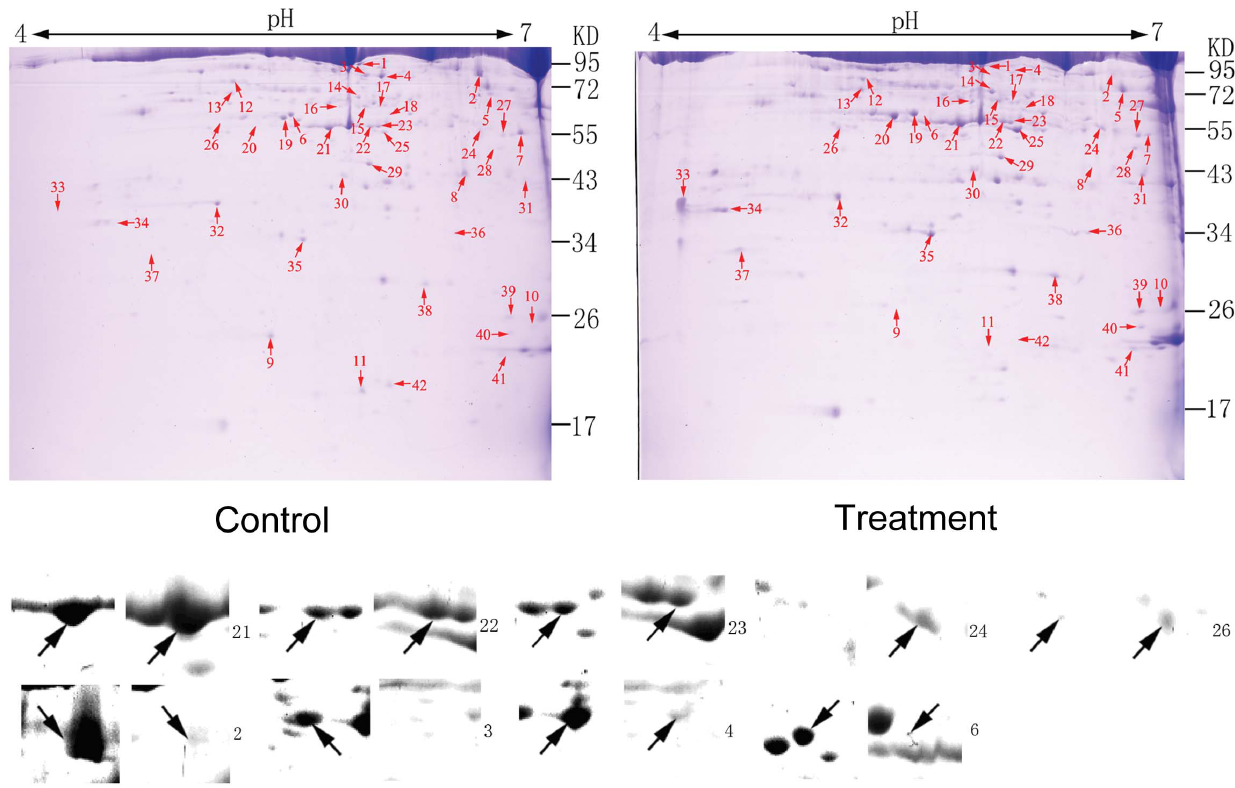
Figure 3. Two-dimensional electrophoresis map of hemolymph proteins. Note: 4 th instar larvae of Plutella xylostella were treated with destruxin A for 4 hour. Hemolymph proteins (1 mg) were separated on 2D gels (pH 4–7) and stained with Coomassie Brilliant Blue R-250. The differential expression and successfully identified protein spots are number, corresponding to the number in Table S2.